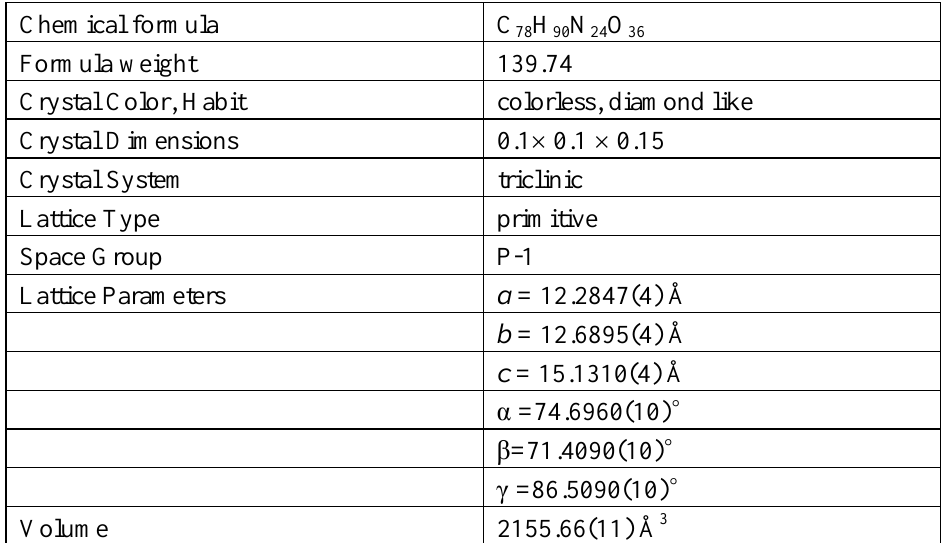
Table 1. Crystallographic parameters for